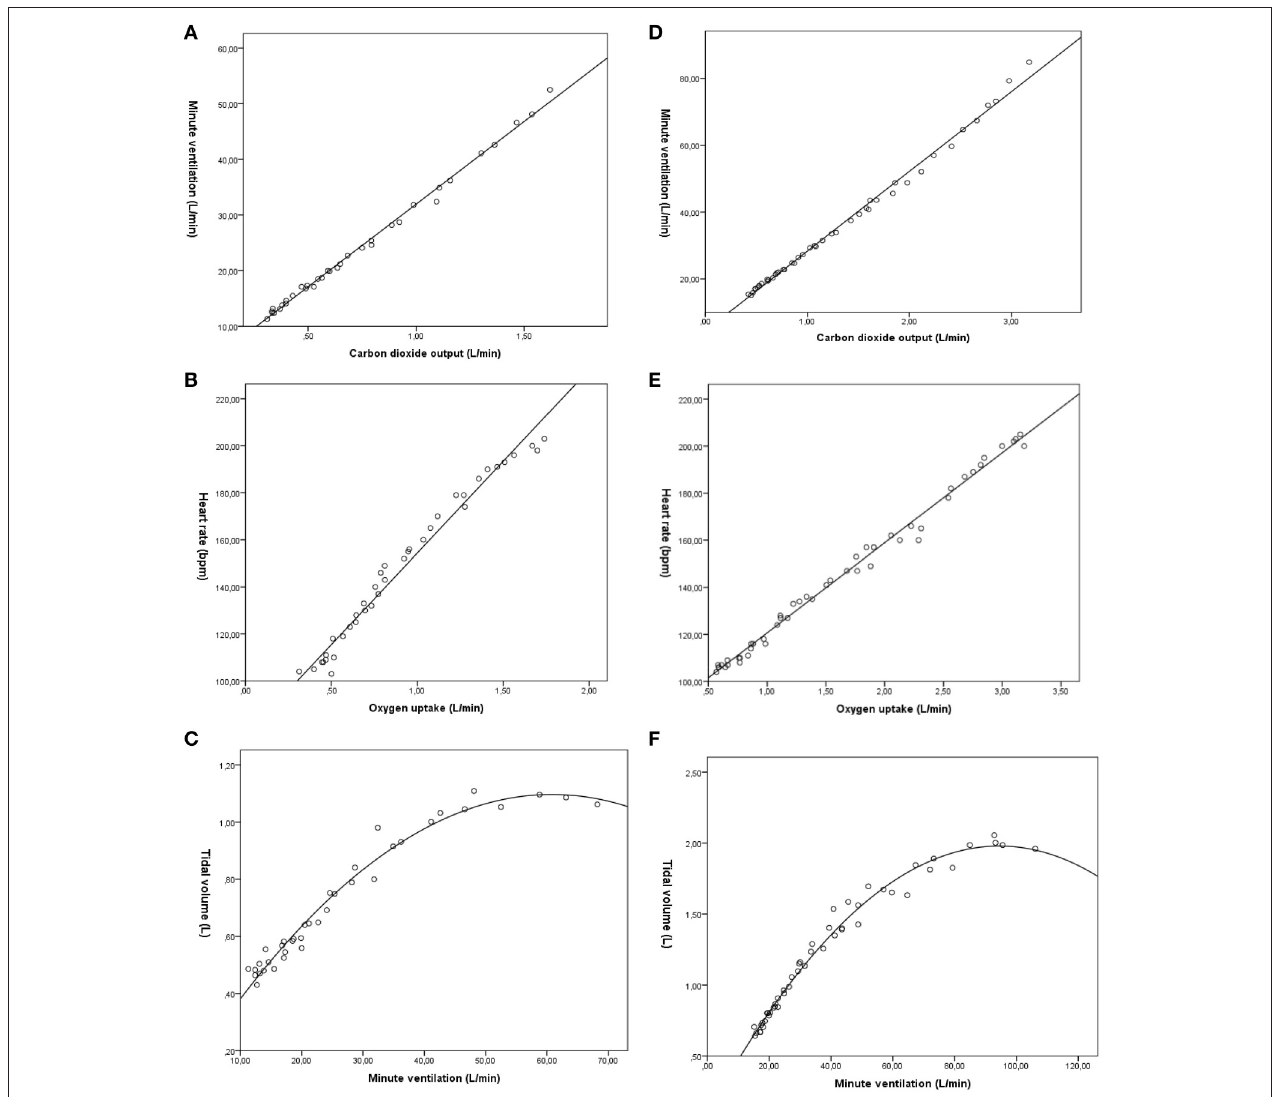
FIGURE 1 | The relationships between ventilation and carbon dioxide output, heart rate and oxygen uptake, and tidal volume and ventilation. Two randomly selected participants, one from the 1991–1992 cohort at 10 years of age (left column A–C ), and one from the 1982–1985 cohort at 18 years of age (right column D–F